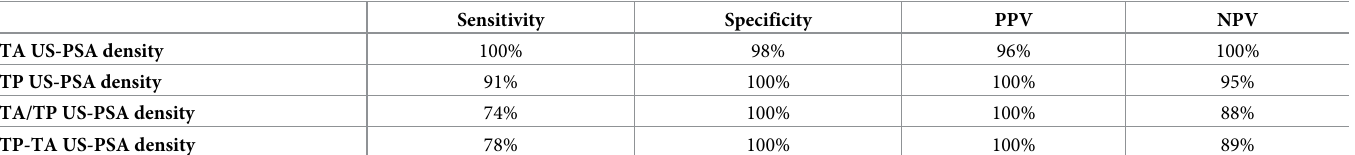
Table 6. Sensitivity, Specificity, Positive predictive value (PPV), Negative predictive value (NPV) between MRI-PSA density and each US PSA density for the deci- sion to biopsy at PSA threshold > 0.15 ng/mL 2 .